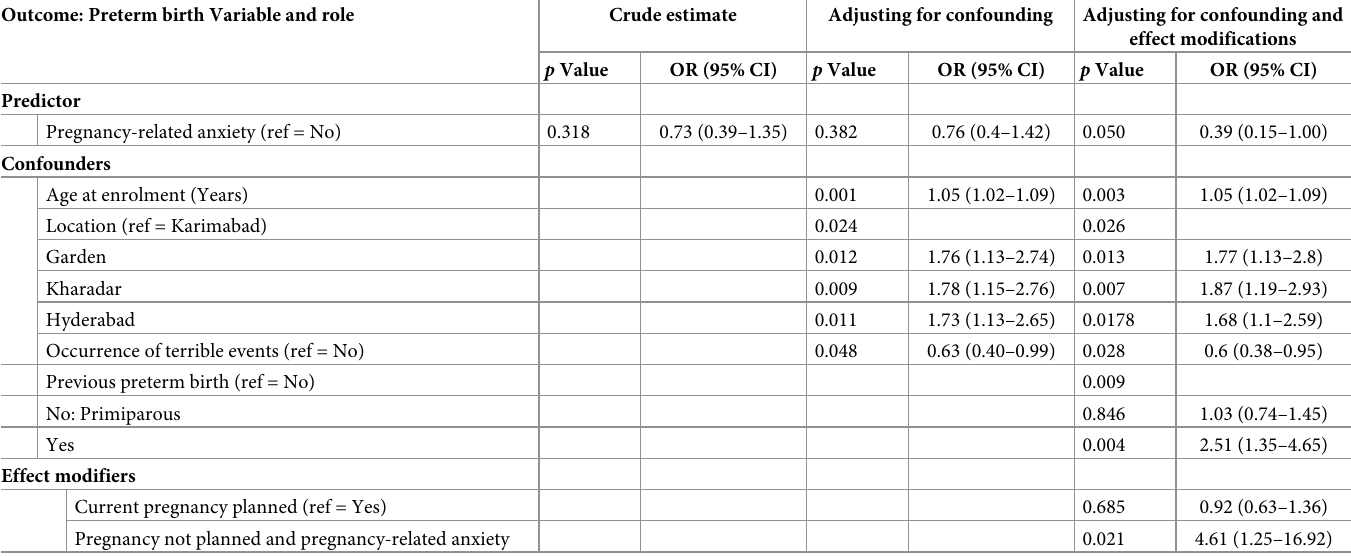
Table 2. Model for preterm birth given pregnancy-related